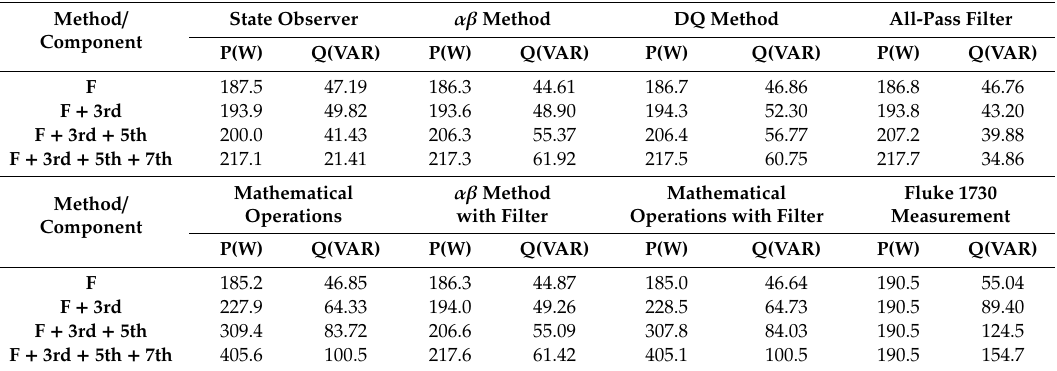
Table 2. Experimental results for RL load.